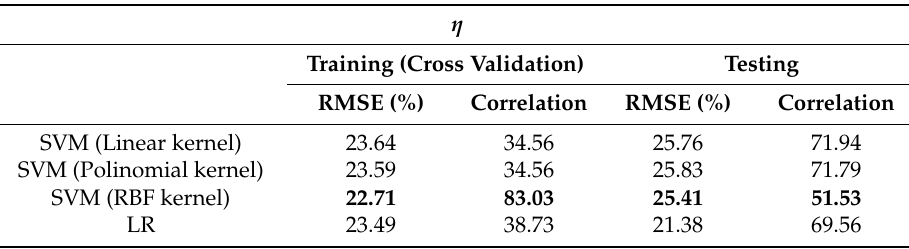
Table 8. Results obtained during the training and testing stages for η .